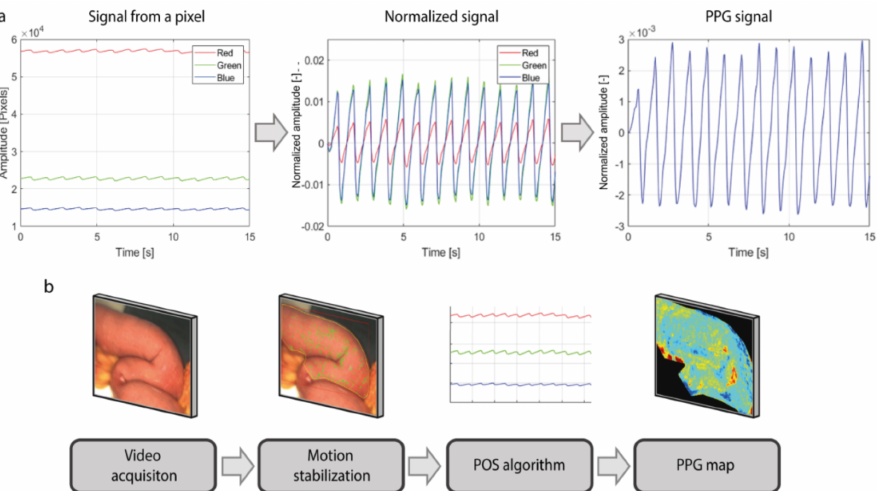
Figure 2. Workflow for data processing. ( a ) Plane-Orthogonal-to-Skin (POS) algorithm for PPG signal extraction. First, the PPG signals from the red, green, and blue channels of the video are extracted. Then, the pulsatile component AC of the signal of each pixel is normalized for its baseline color component DC. Afterwards, red, green, and blue signals from each pixel are combined. ( b ) Schematic overview of the workflow for building PPG maps of perfusion. After video acquisition, motion stabilization is applied to the region of interest. Afterwards, the POS algorithm is used to extract the PPG signal from each pixel and, eventually, the PPG maps are obtained using the Lock-in amplification algorithm.